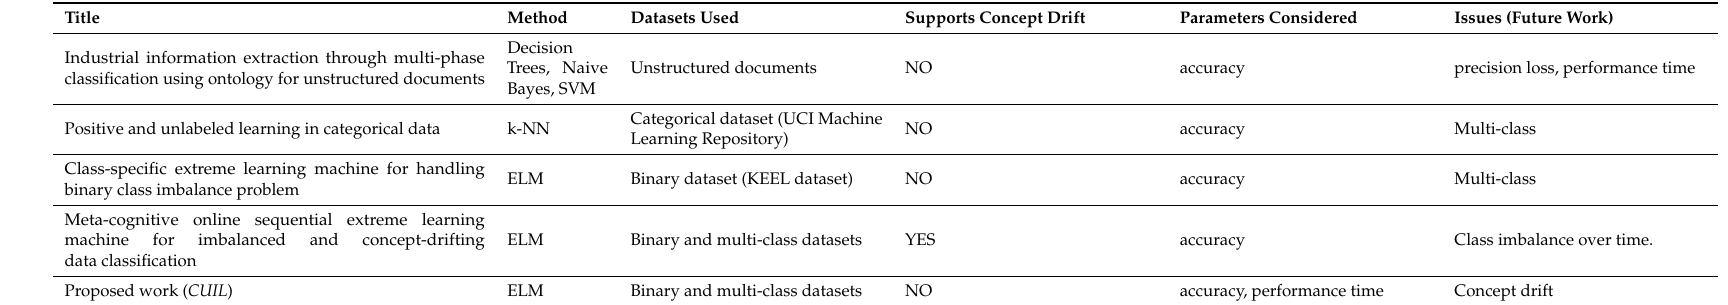
Table 2. Comparison between the related works and CUIL